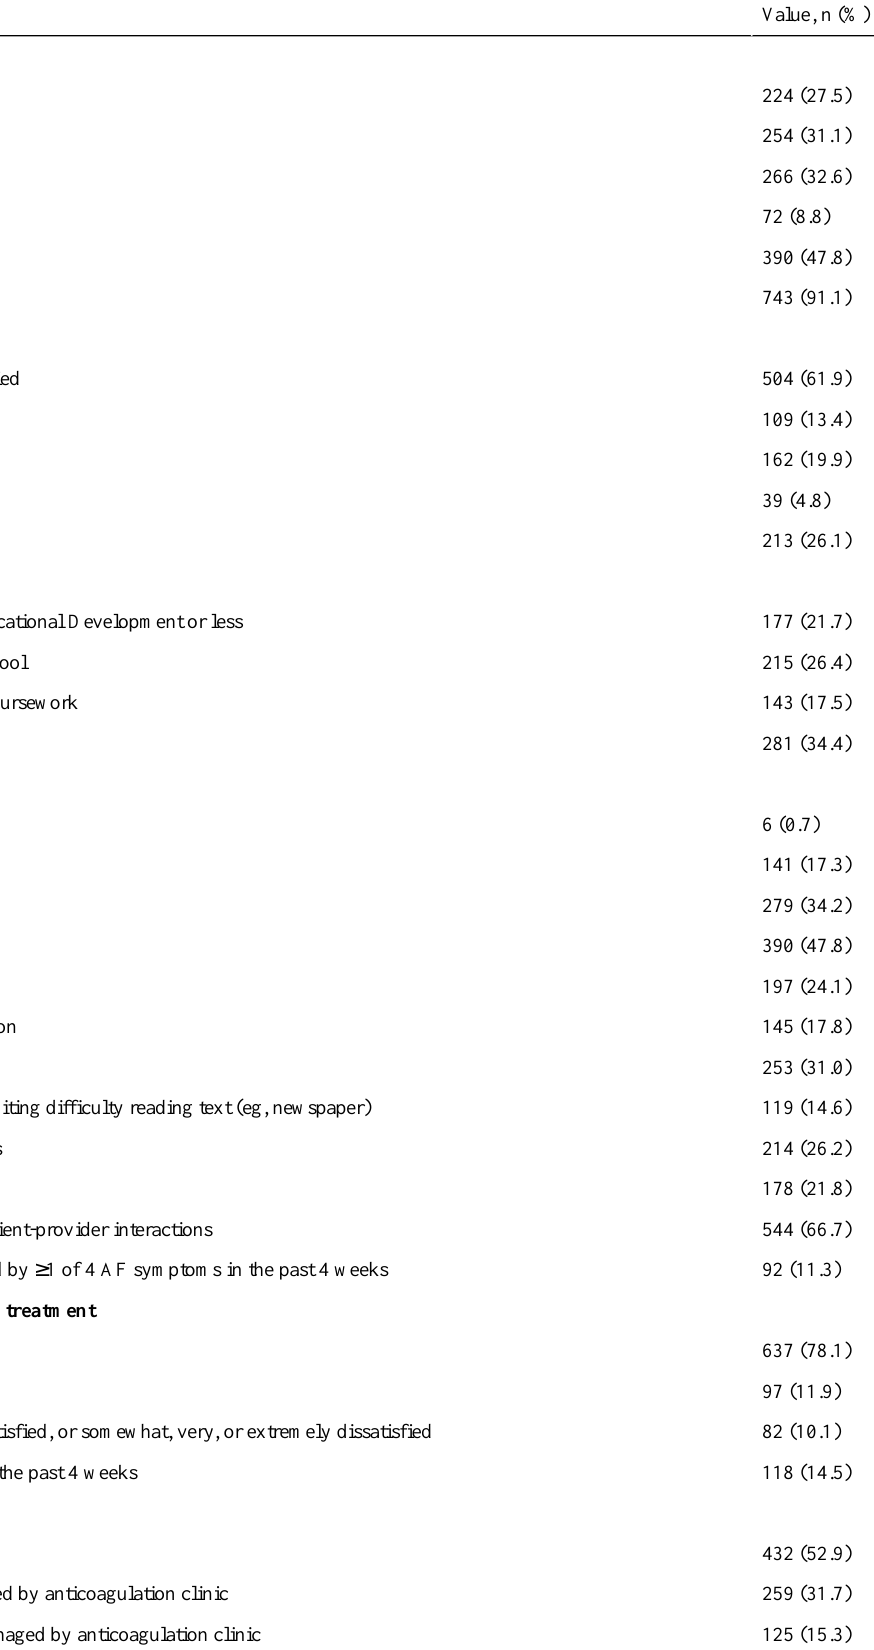
Table 1. Demographic, clinical, and psychosocial characteristics of older adults with atrial fibrillation (AF) who used the internet (N=816), Systematic Assessment of Geriatric Elements in Atrial Fibrillation (SAGE-AF)